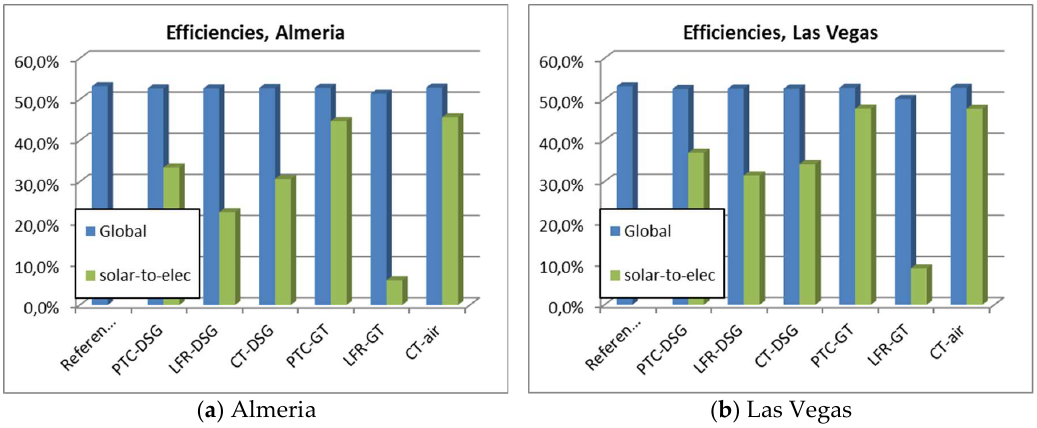
Figure 10. Global and solar-to-electricity efficiencies.